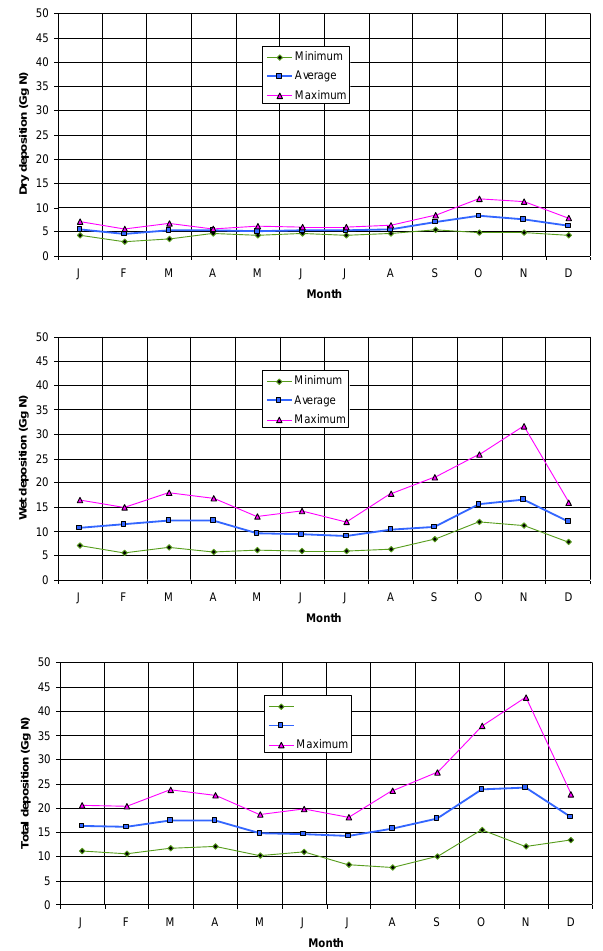
Fig. 11. Monthly minimum, maximum and monthly average (over 12yr) deposition of dry, wet and total nitrogen to the Baltic Sea basin in the period